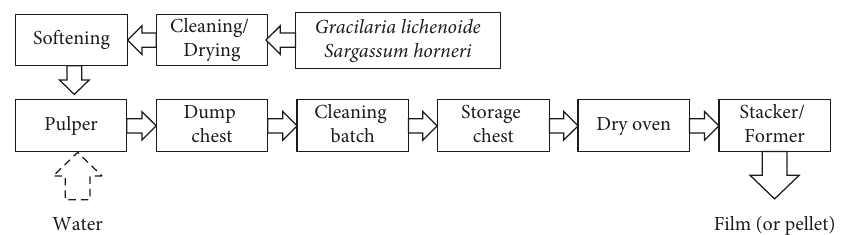
Figure 1: Synthesis process of the present biodegradable